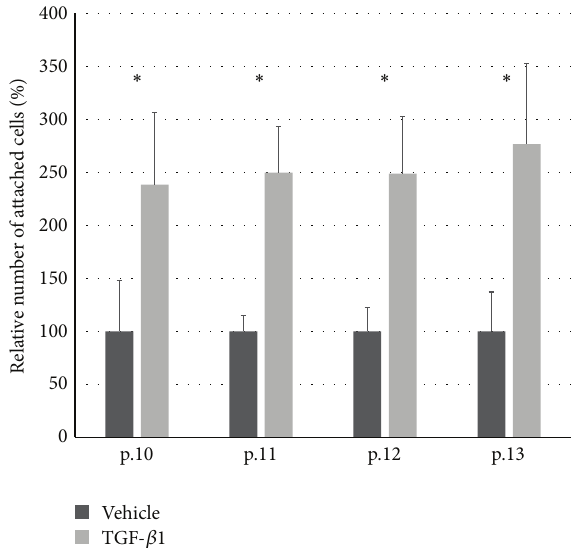
Figure 3: Expression levels of 𝛼 3- and 𝛽 1-integrin subunits in cul- turedmousepodocytes(HSMP)treatedwithTGF- 𝛽 1.Differentiated HSMP were cultured with 1ng/mL TGF- 𝛽 1, and the expression levels of 𝛼 3- and 𝛽 1-integrin were measured by semiquantitative real-time PCR. The relative mRNA level at each time point is representedasapercentageofthebaselinevalue(0hours). ∗ 𝑝 < 0.05 versus the baseline value.